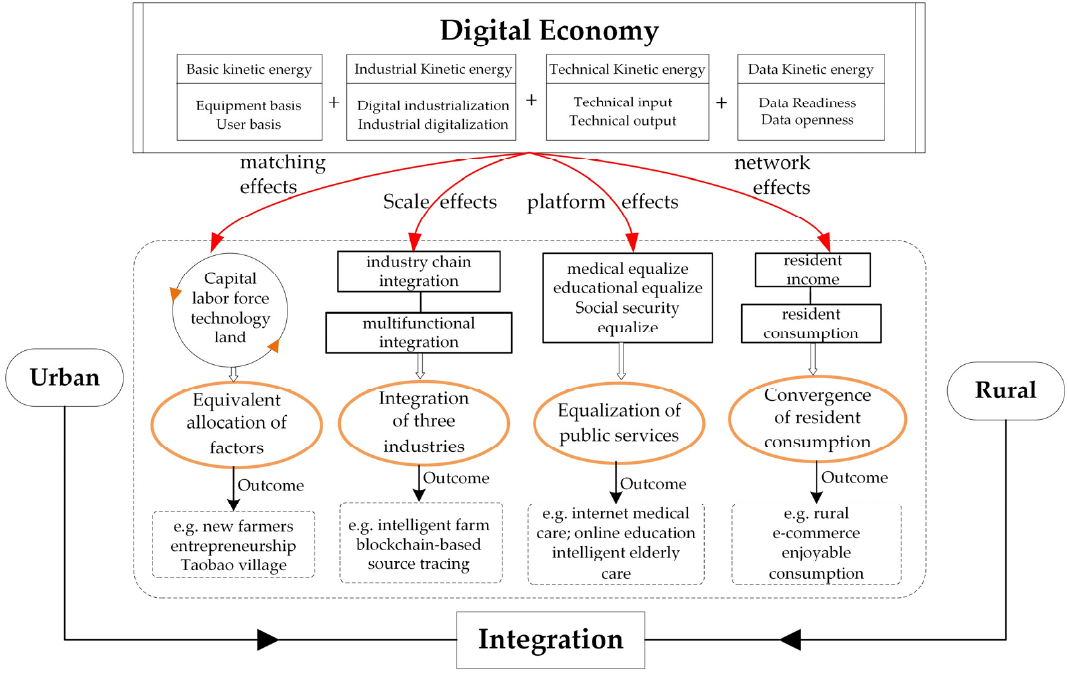
Figure 1. Intrinsic mechanisms.